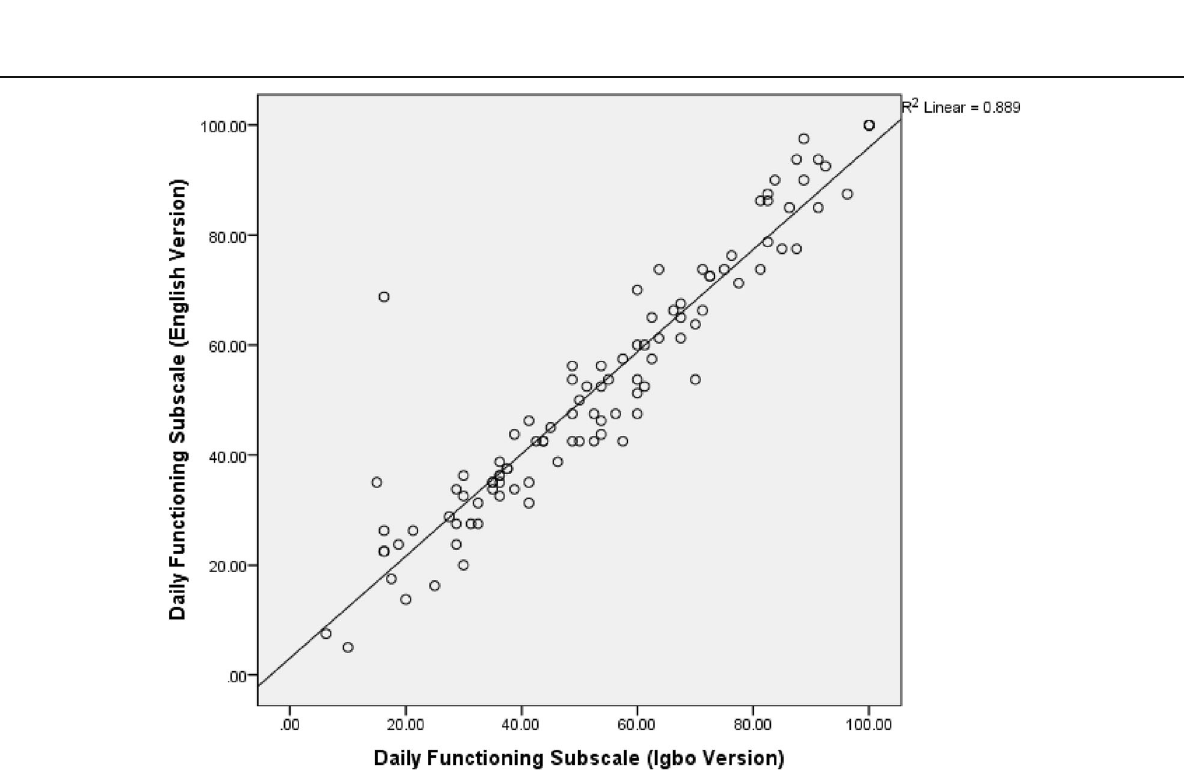
Fig. 2 Scatter Diagram for daily functioning subscale scores on the E-RNLI and the I-RNLI. KEY : I-RNLI = Igbo version of Reintegration to Normal Living Index. E-RNLI = English version of Reintegration to Normal Living